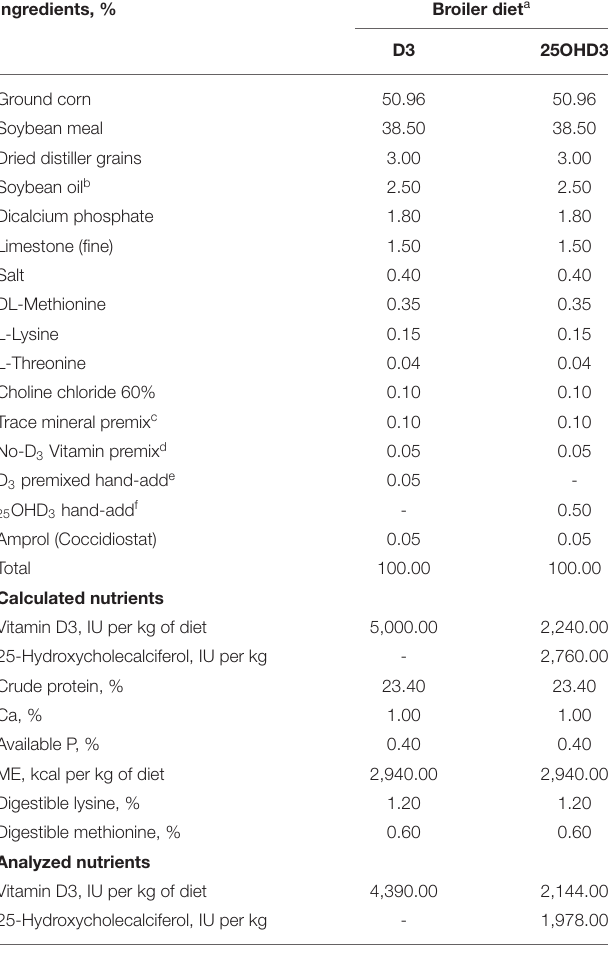
TABLE 1 | Composition of broiler diets. Ingredients,